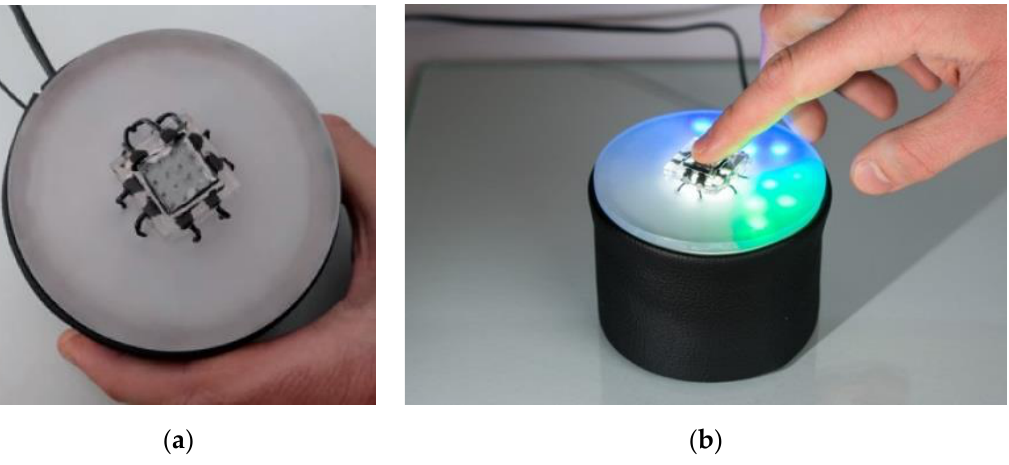
Figure 23. Human – machine interface: a pressure sensor with an elastomer frame containing four electrically conducting zones ( a ) to close an electrical contact via shear motion of a finger on the pressure sensor, which selects an LED and fixes the tuned brightness of the selected LED ( b ) [104]. A step forward is the integration of soft capacitive pressure or strain sensors into textiles worn on the human body. A simple demonstrator is shown in Figure 24, which comprises a wristband containing four pressure sensors. By pressing a finger onto one of the pressure sensor fields, the user can continuously control an arbitrary technical function of an electronic device worn on his or her body with the force of the finger. However, the device, which has to be controlled by the wristband, can also be located at a larger distance from the user and thus is operated by a remote control. As depicted in Figure 24d, the strength of the applied pressure on a sensor of the wristband is made visible on a computer display with data transmission via Bluetooth.